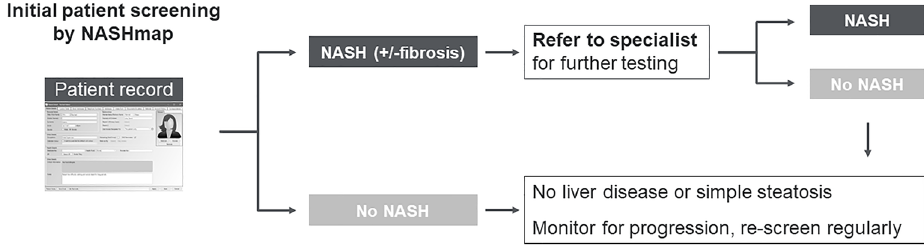
Figure 1. Initial NASHmap screening of patients for referral